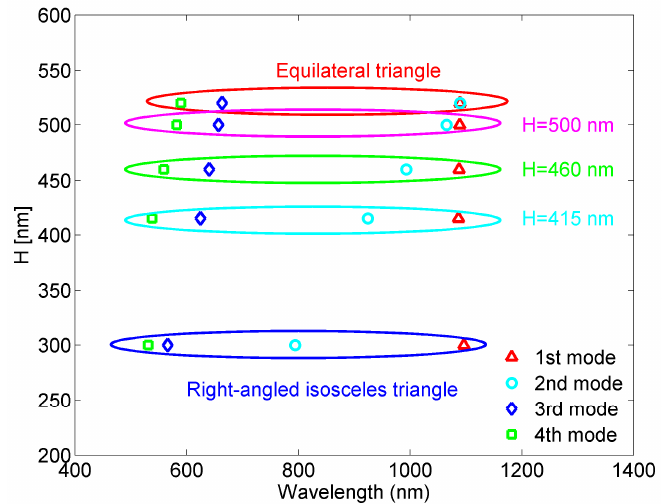
Figure 3. Spectral mode distribution for different types of triangular cavity resonators .